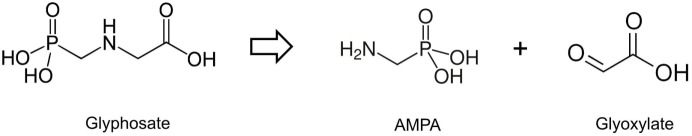
Structure of glyphosate and its breakdown products aminomethylphosphonic acid (AMPA) and glyoxylate.